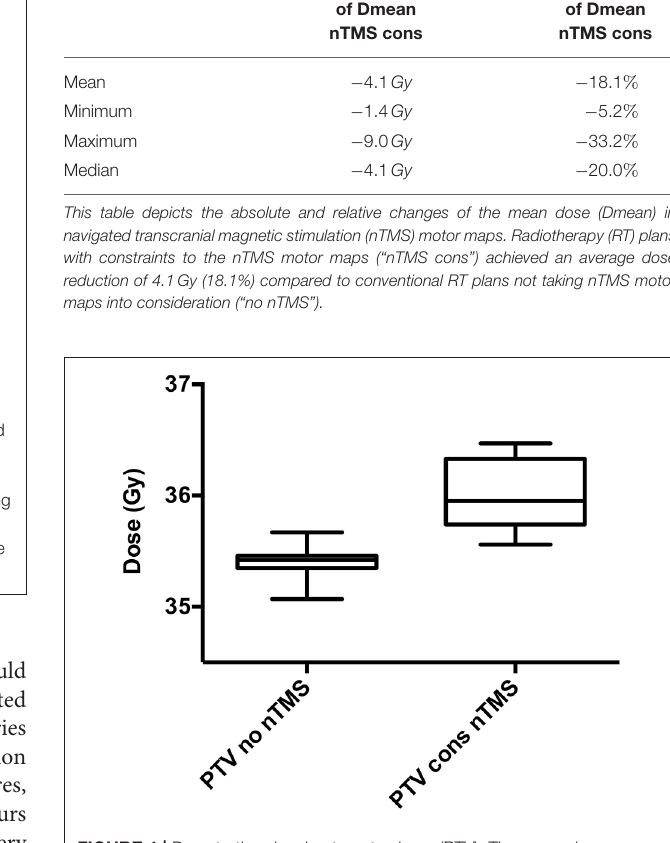
FIGURE 4 | Dose to the planning target volume (PTV). The mean dose (Dmean) to the PTV for conventional radiotherapy (RT) plans not taking nTMS motor maps into consideration (“PTV no nTMS”) and with dose constraints to nTMS motor areas (“PTV cons nTMS”) is depicted in these box plots. A minor but significant increase of the Dmean from 35.4 ± 0.1Gy to 36.0 ± 0.3Gy was observed ( p <